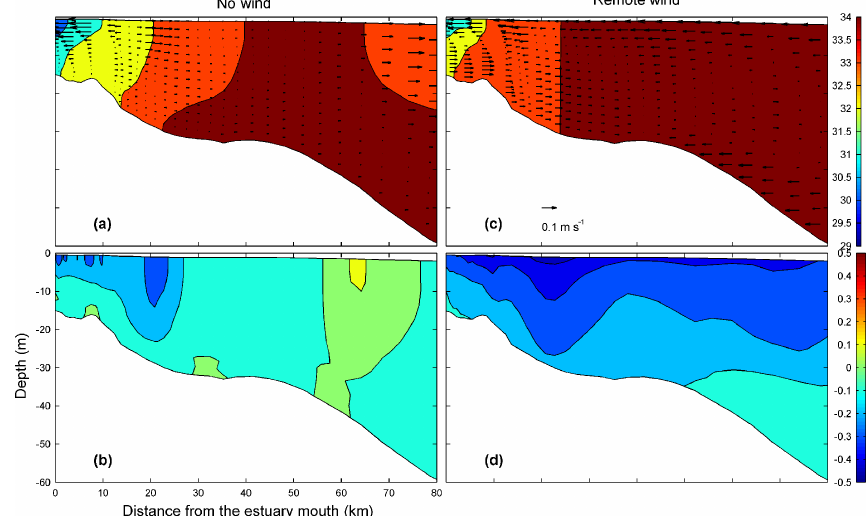
Figure 10. Comparison of 50h averaged current and salinity at the T3 section (on the continental shelf) during the spring tide. Panel (a) salinity (units: ppt) and cross-shore current in Case 1; panel (b) alongshore current (units: ms − 1 ) in Case 1; panel (c) salinity and cross-shore current in Case 3; panel (d) alongshore current (units: ms − 1 ) in Case